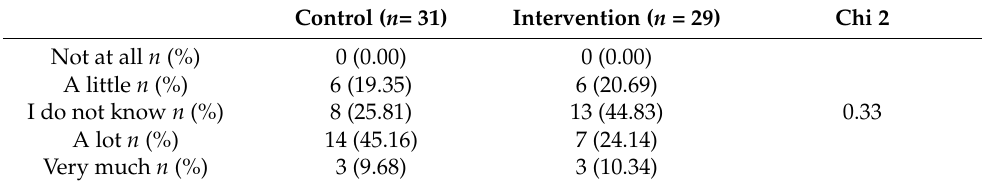
Table 2. Representation of the effectiveness of honey before